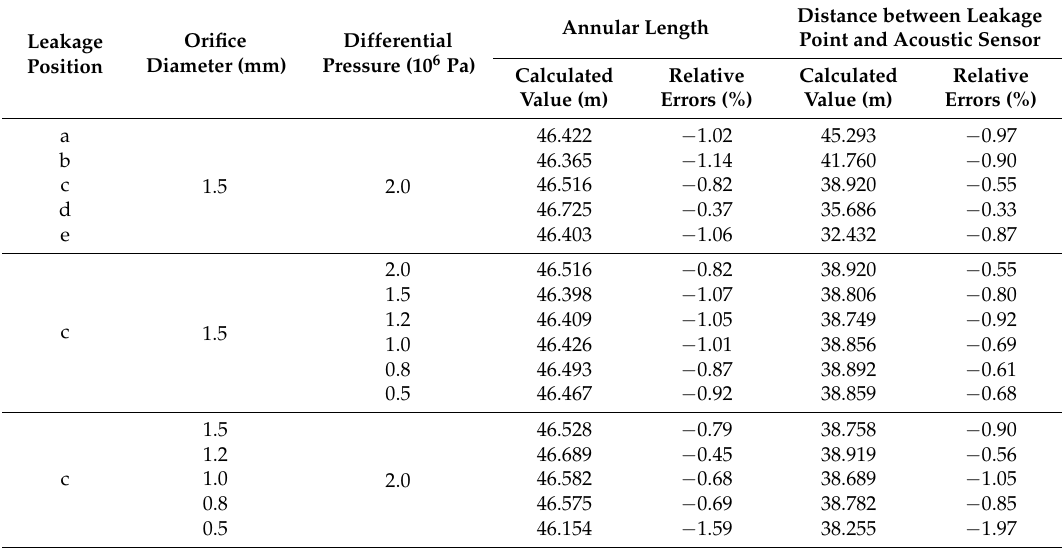
Table 2. Leak localization results under different experimental conditions.